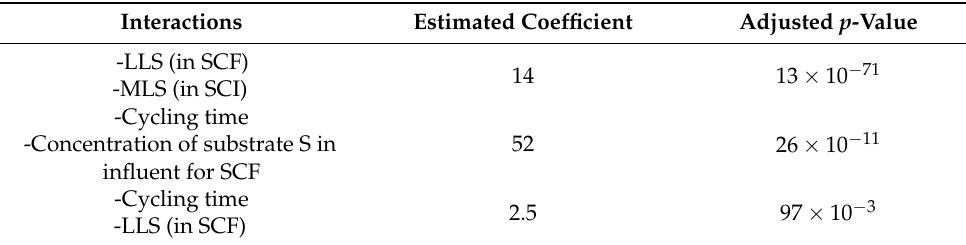
Table 2. Parameter interactions by determined by multiple linear regression around the optimum parameter